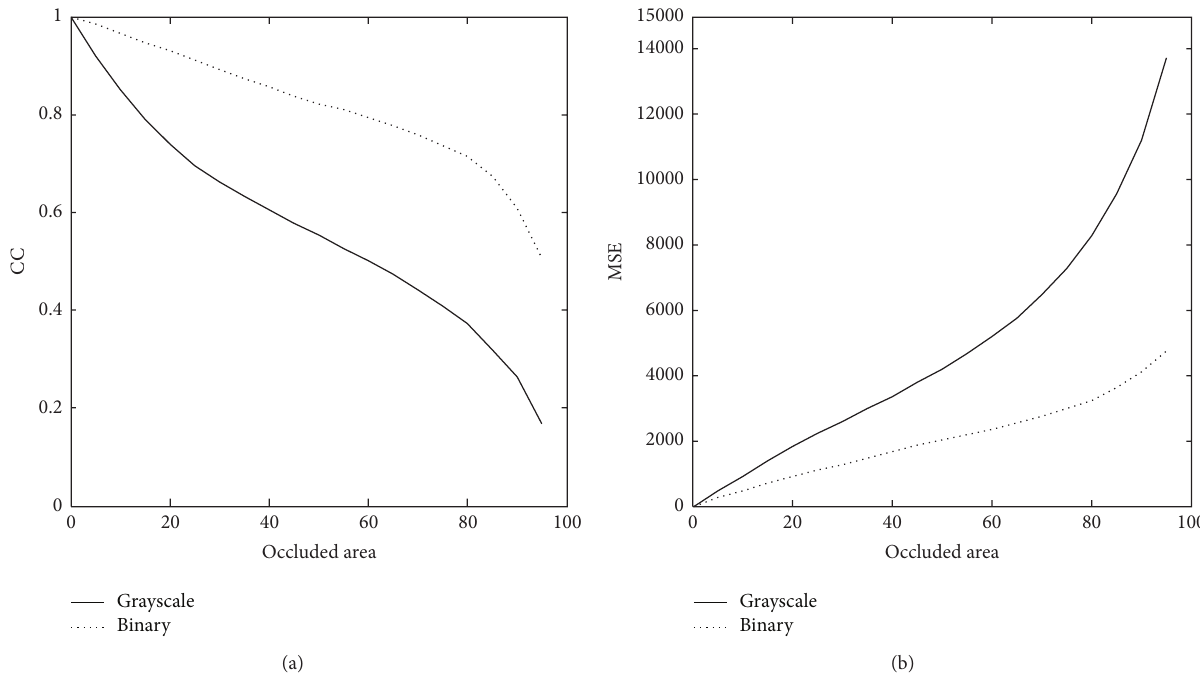
Figure 10: Plots of (a) correlation coefficient and (b) MSE for grayscale and binary images with varying occluded area.